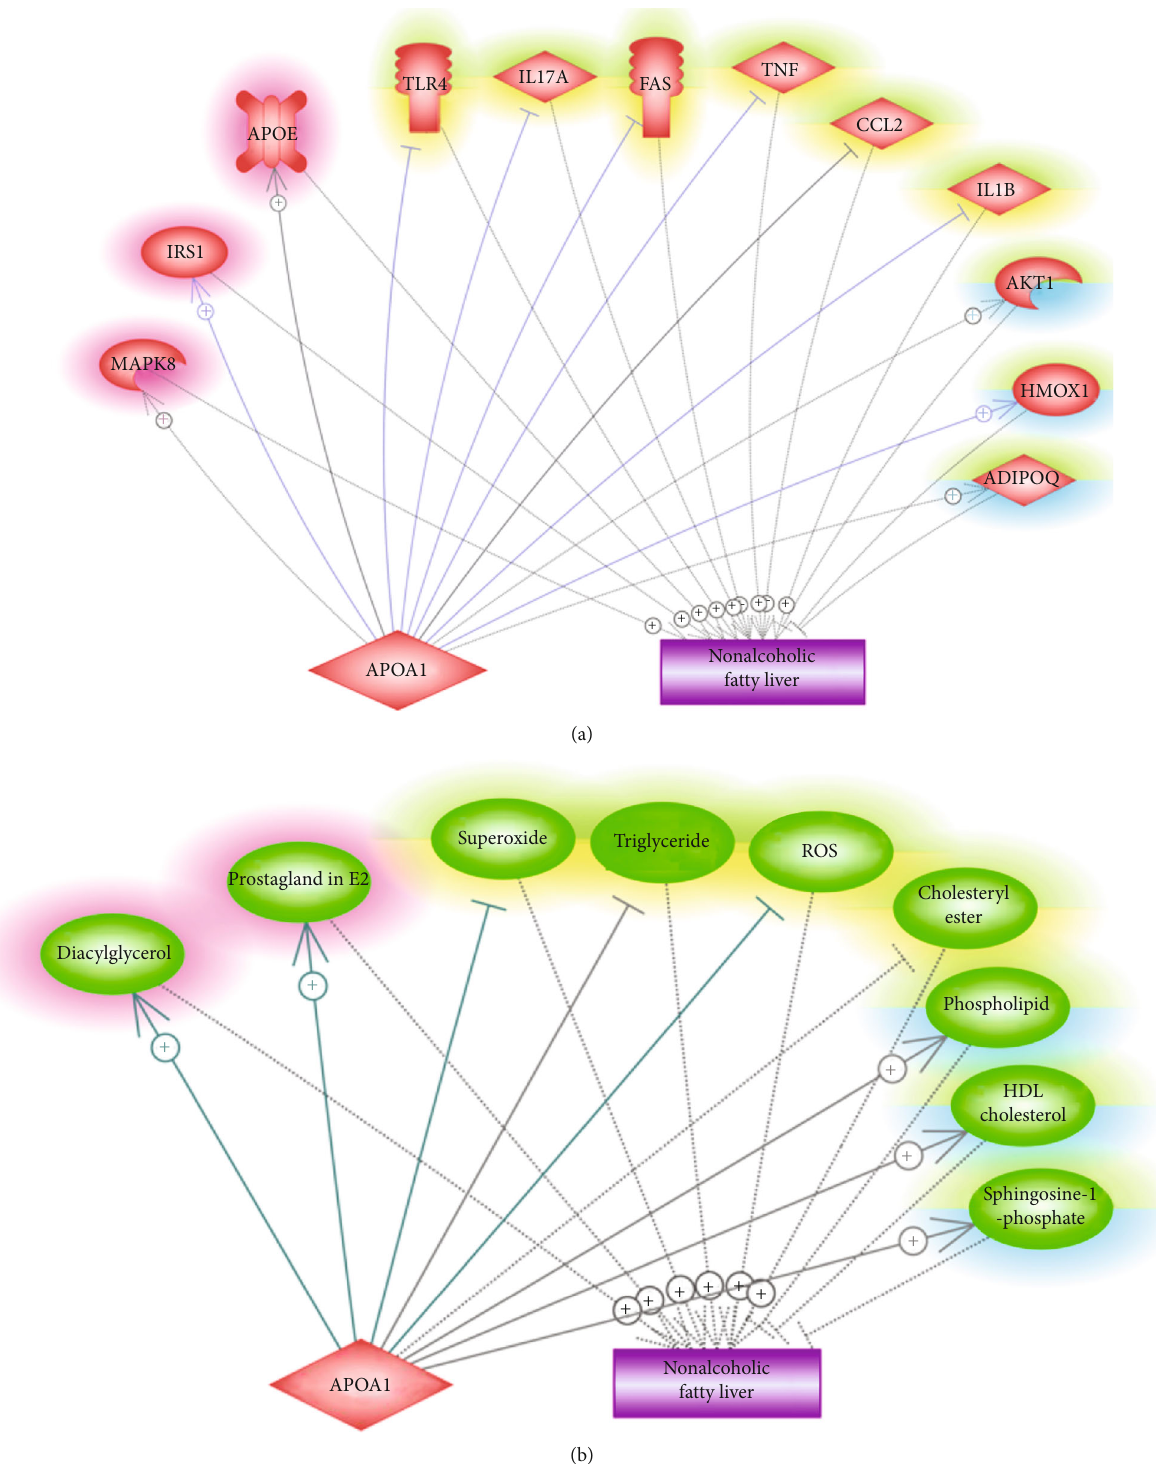
Figure 2: Molecule pathways that decode the APOA1-NAFLD relationship. (a) The APOA1-driven genetic pathway. (b) The APOA1- driven small molecular